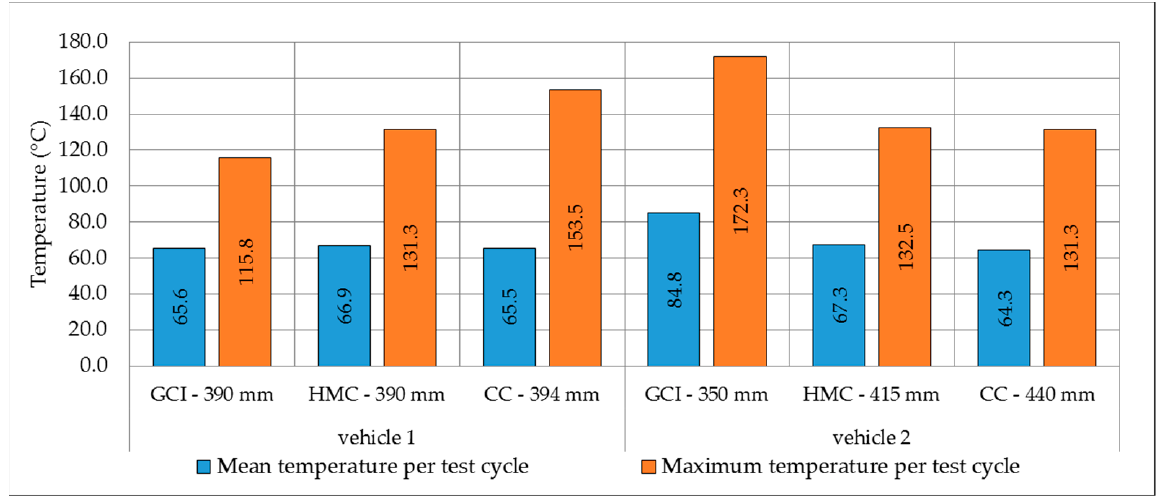
Figure 12. Comparison of the average and maximum temperatures of the different friction materials (Vehicles 1 and 2)—WLTP brake cycle trip #10.